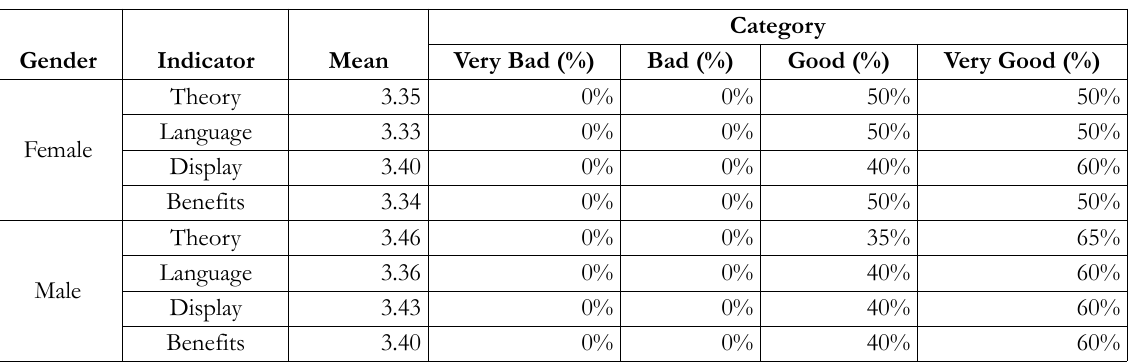
Table 10. Ninth Grade Student’s Perception of the Use of Web-based